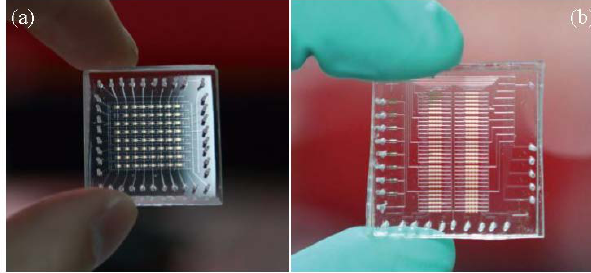
Figure 4: (a) 8 × 8 microfluidic chip with independent channels. Taken from Ref. [27]. (b) Logic microfluidic chip.